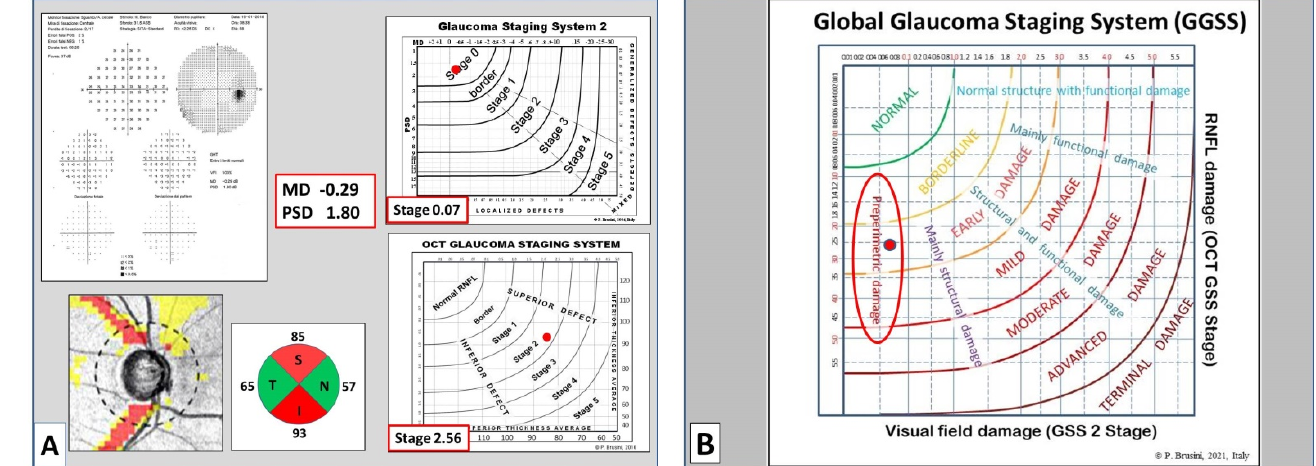
Figure 7. ( A ) 58 year old woman with primary OAG with a normal visual field (GSS 2 Stage 0.07) and a superior and inferior nerve fiber defect (OCT GSS Stage 2.56). This case was classified as Stage 1 using the clinical classification; ( B ) the GGSS classifies it as a preperimetric glaucoma at an early stage.